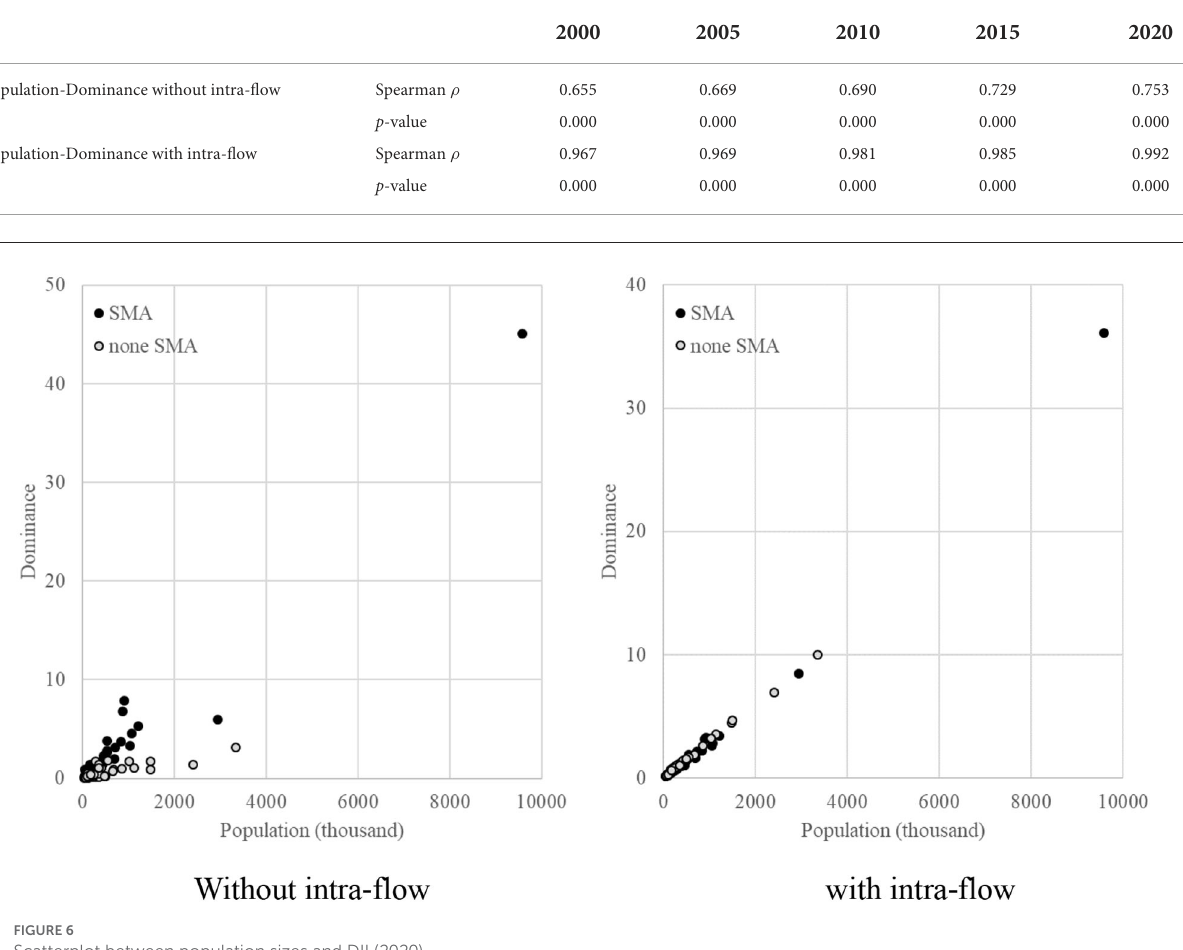
TABLE 6 Rank correlation between population and DII.